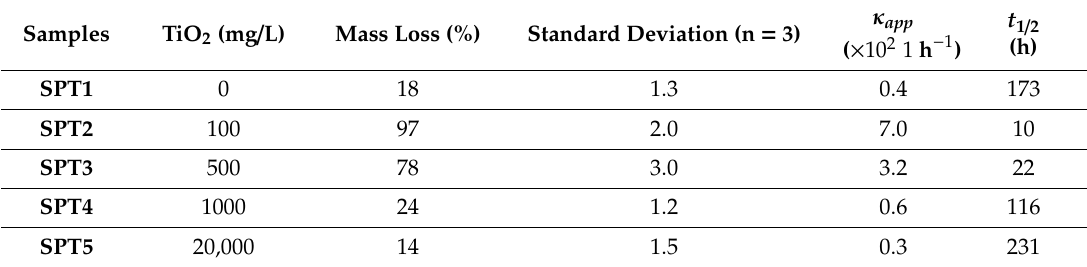
Table 4. Apparent reaction constant ( κ app ) and half-life ( t 1 / 2 ) calculated for SPT1 to SPT5, where di ff erent concentrations of TiO 2 from 0 to 20,000 mg / L were